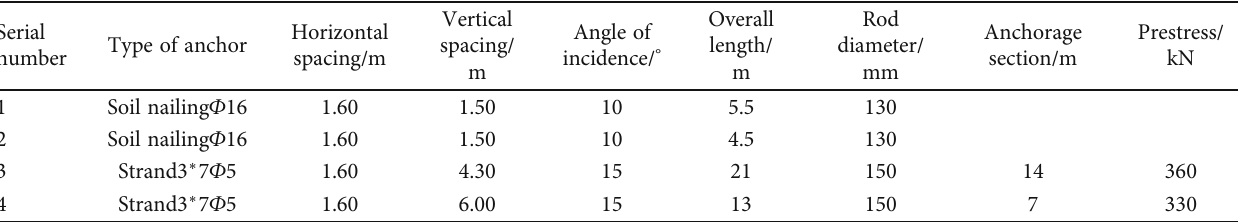
Table 2: Design parameters of soil nails and prestressed anchors.